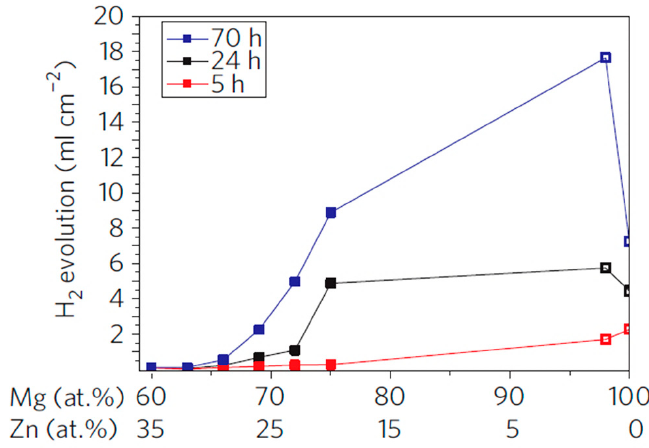
Figure 26. Hydrogen evolution measurement for MgZnCa alloys with different content of Zn. Reproduced with permission from [80], Nature Publishing Group, 2009.